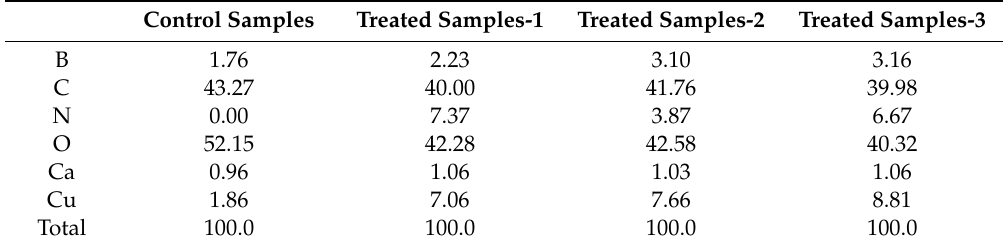
Table 2. Elements distributions with cell wall by SEM-Energy Dispersive Spectrometer (EDS).